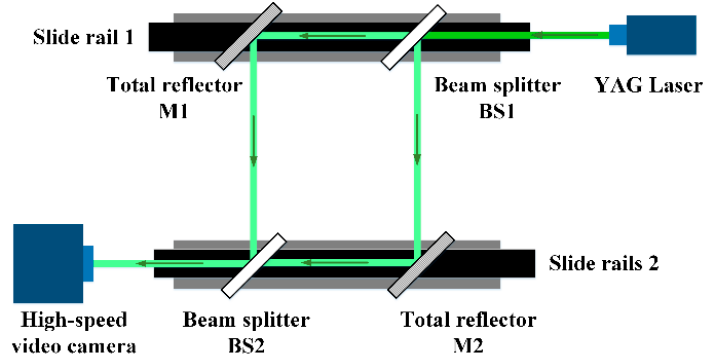
Figure 1. Schematic diagram of a Mach–Zehnder (M–Z) interferometer.